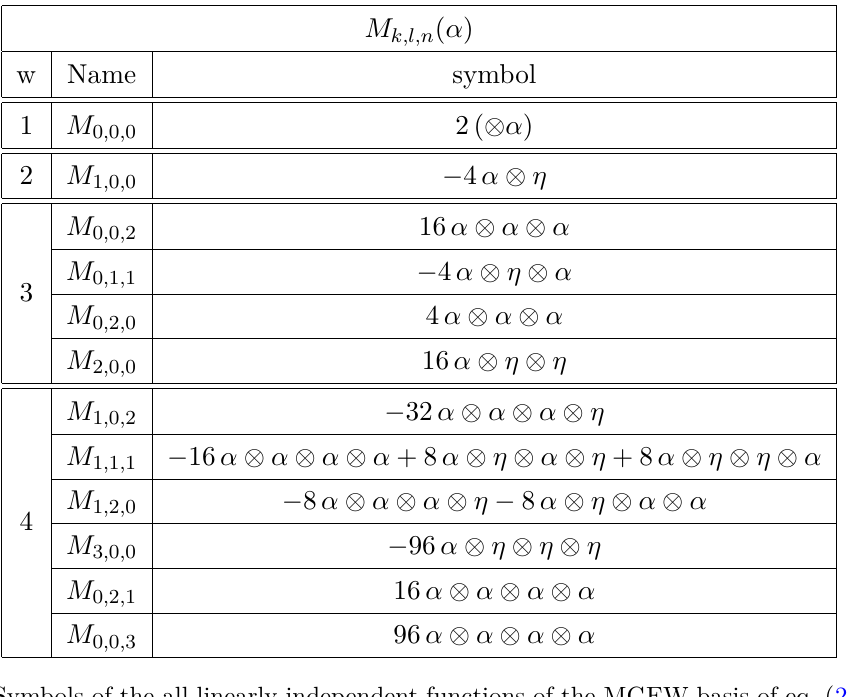
Table 3 . Symbols of the all linearly independent functions of the MGEW basis of eq. (2.51) up to weight 4 .